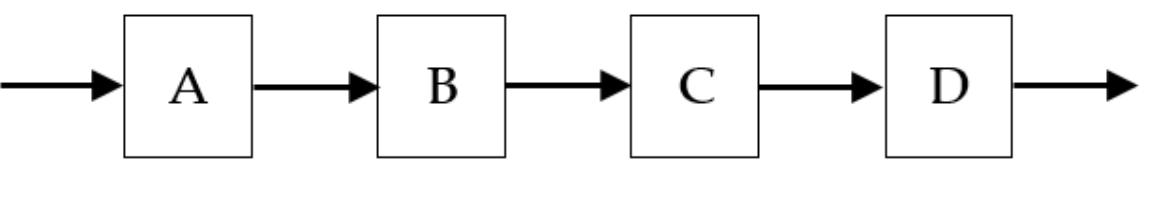
Figure 1. Traditional assembly line.